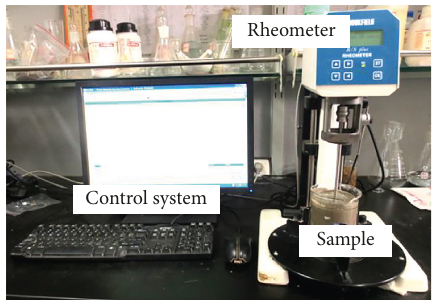
Figure 4: The picture of the Brookfield R/S+ Rheometer.